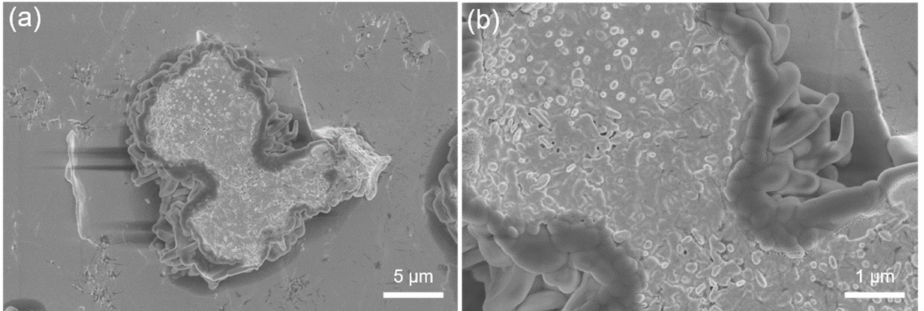
Figure 5. Surface morphology of wear scar edge of SA20H, ( a ) low magnification, ( b ) high